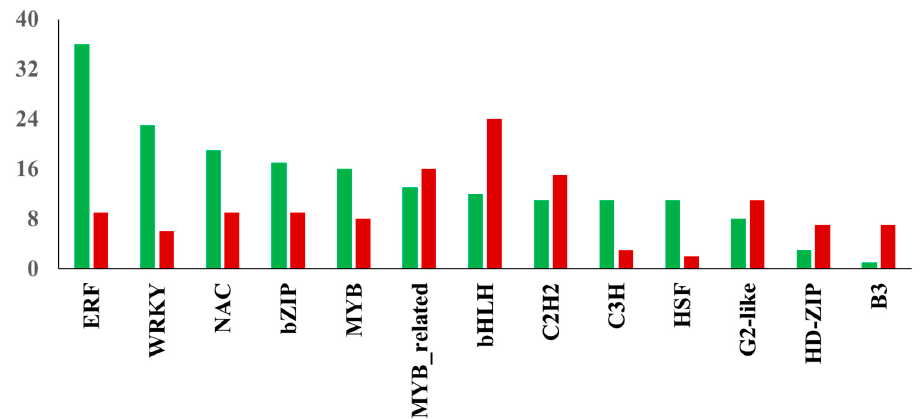
Figure 6. Distribution of transcription factor families. The red and green bars show the total number of down-regulated and up-regulated TFs in the respective family, respectively.